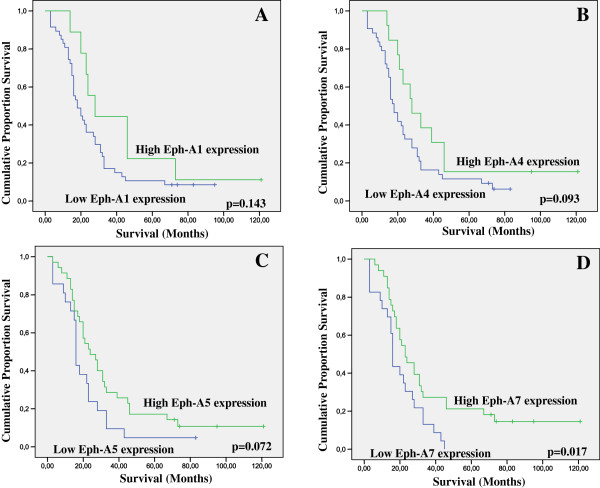
Kaplan-Meier survival analysis stratified according to A. EphA1, B. EphA4, C. EphA5 and D. EphA7 expression in 56 adenocarcinoma-type NSCLC patients (–complete cases; + censored cases).